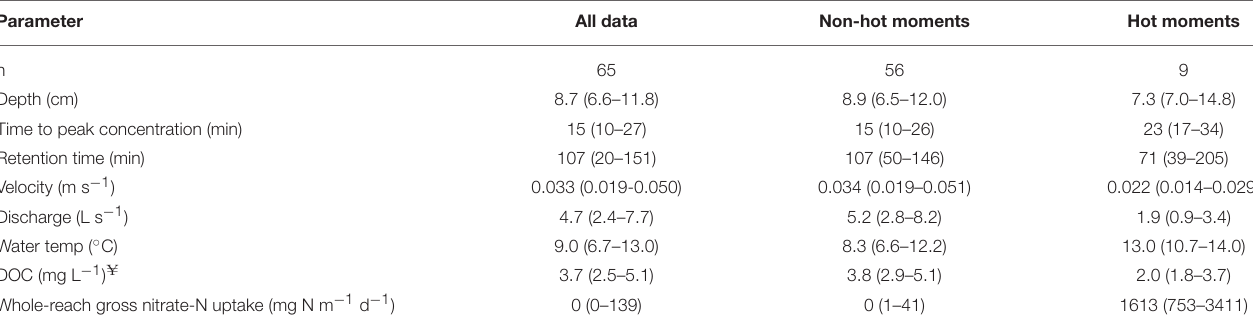
TABLE 3 | Flow characteristics [Median, (interquartile range)] during slug testing to estimate whole-reach gross nitrate-N uptake across six intermittent streams over three years. Parameter All data Non-hot